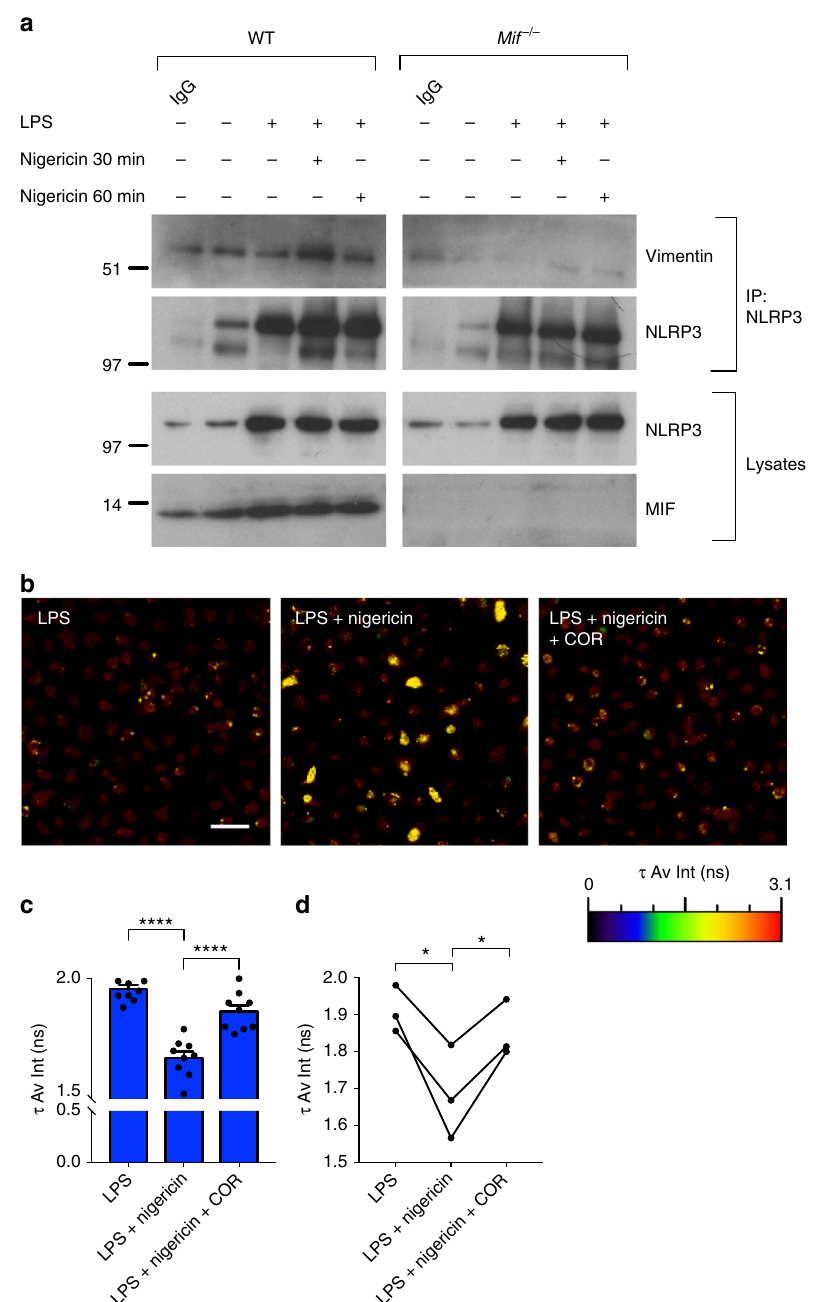
Fig. 6 MIF is required for interactions between NLRP3 and vimentin. a Primary murine WT and Mif − / − BMDMs were left untreated, primed with LPS alone (100 ng ml − 1 ) for 5 h, or primed with LPS before in fl ammasome activation with nigericin (5 µ M) for indicated times. Lysates were immunoprecipitated with anti-NLRP3 antibody, followed by Western blot analysis with anti-vimentin antibody. b WT BMDMs were primed with LPS alone (100 ng ml − 1 ) for 5 h, primed with LPS followed by nigericin (5 µ M) for 1 h, or primed with LPS followed by COR123625 (50 µ M) for 2 h prior to nigericin (5 µ M) treatment for 30 min. Levels of interaction between NLRP3 and vimentin were assessed by FLIM-FRET. FLIM-FRET images presented are representative of three independent experiments (three mice). Scale bar = 50 μ m. c Changes in the amplitude-weighted average lifetime ( τ Av Amp) of the donor (A488) due to proximity to the acceptor (A568). Representative graph from one mouse (nine separate fi elds per mouse). **** P < 0.001, one-way ANOVA with a correction provided by the Tukey's multiple comparisons test. d Combined data from three mice, analyzed by paired t test. * P <